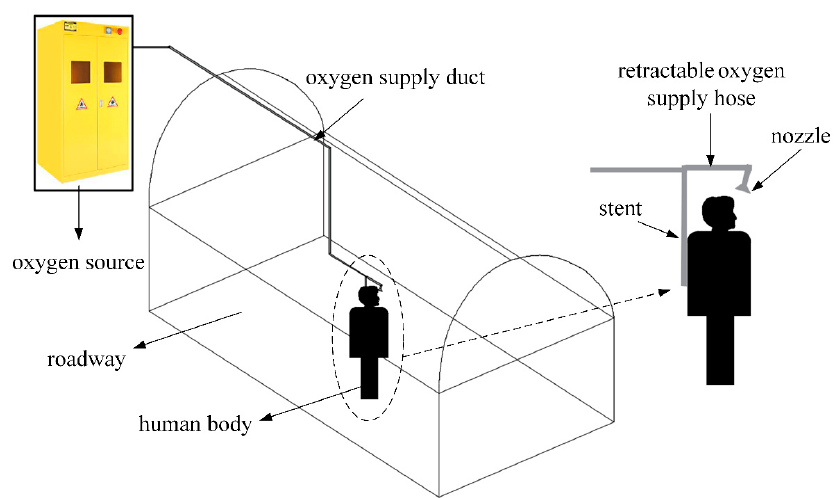
Figure 1. Diagram of individual oxygen-supply